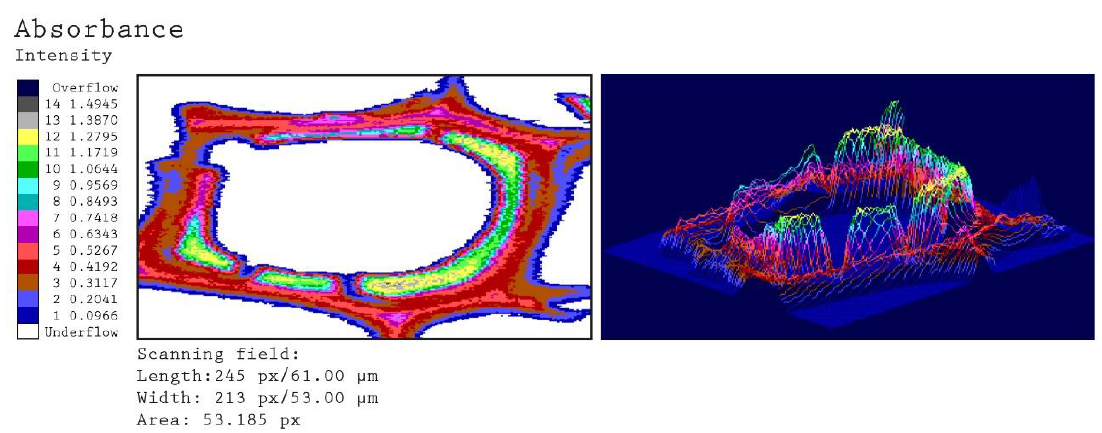
Figure 6. Representative UV microscopic image profiles of an individual tracheid from adhesive-covered sample. The colored scale indicates the different UV-absorbance values at a wavelength of 280 nm.